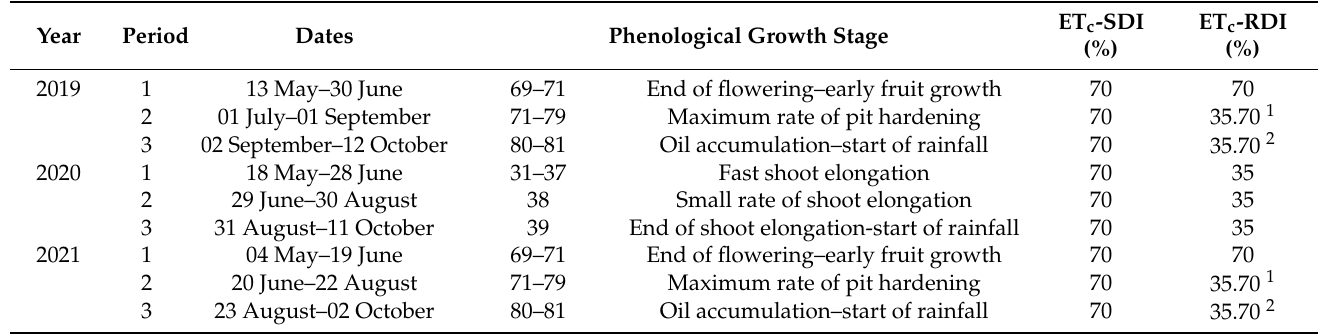
Table 1. Phenological growth periods during 2019–2021 used for the water balance computations and analysis of plant observations and the percentage of crop water requirements (ET c ) for the sustained (SDI) and regulated (RDI) deficit irrigation